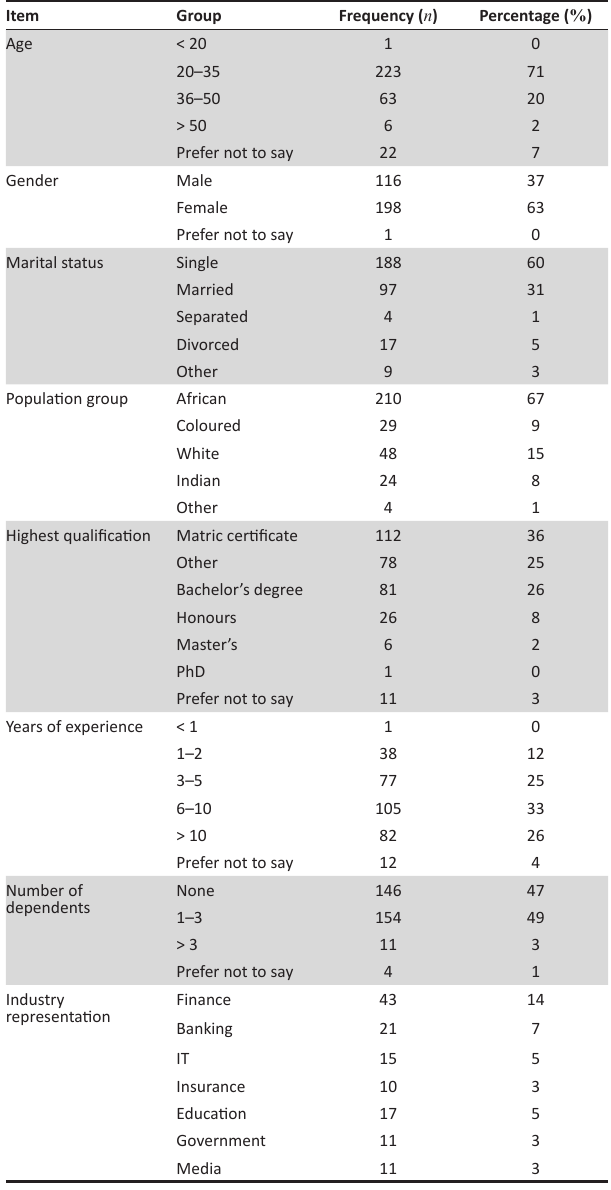
TABLE 1: Biographical and demographic profile of respondents ( N =